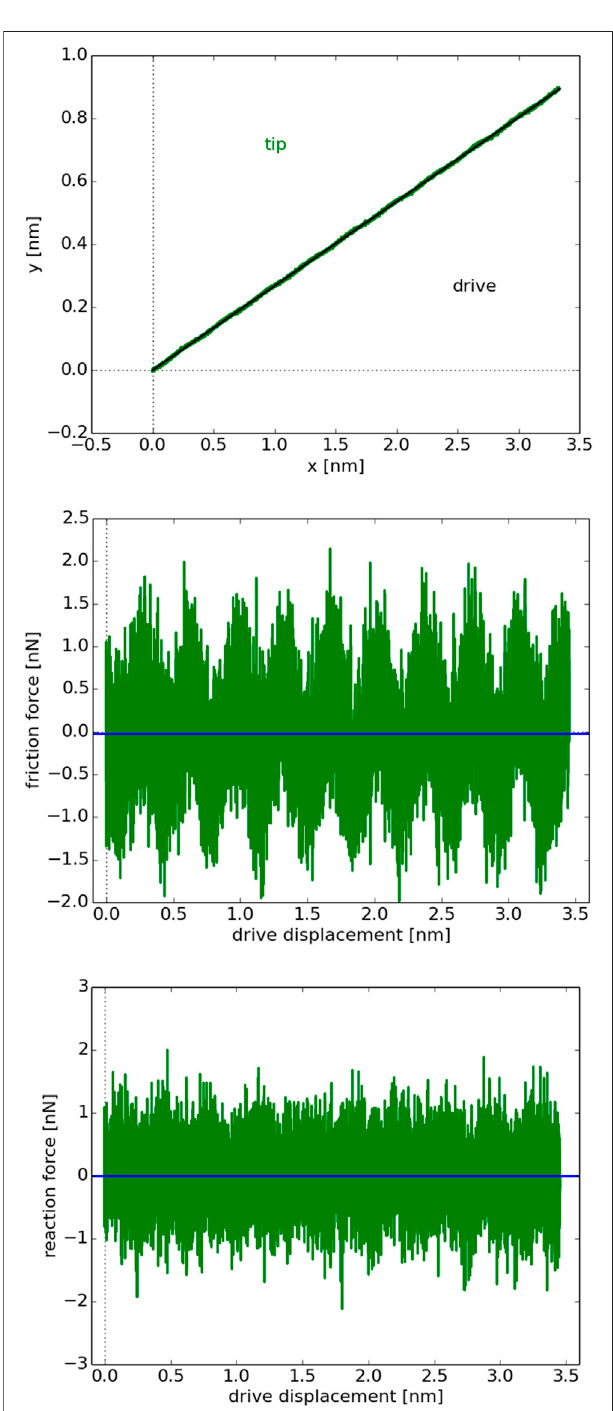
FIGURE2 | Asin Figure 1 , foran η -valueleadingtoa superlubric sliding of the AFM-tip on an fcc(111) substrate.